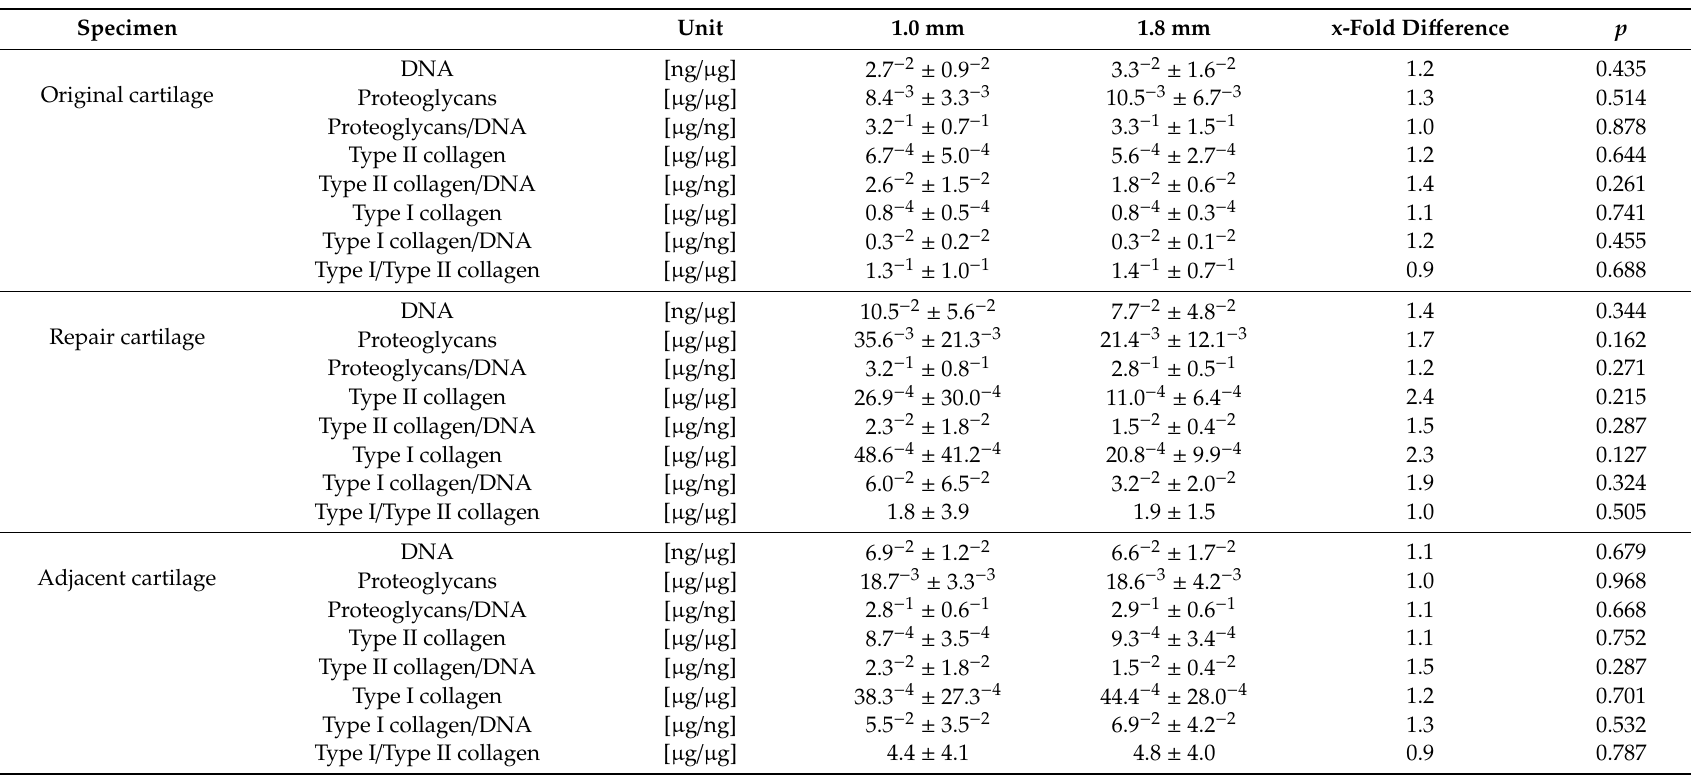
Table 1. Overview of the biochemical parameters obtained within original cartilage, repair cartilage, and adjacent cartilage.